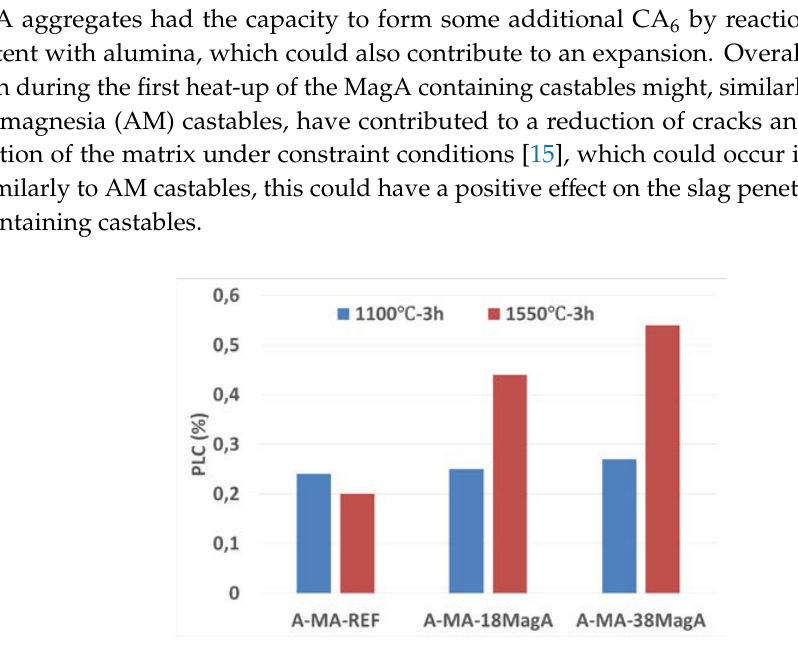
Figure 4. Permanent linear change (PLC) after firing at 1100 °C and 1550 °C.